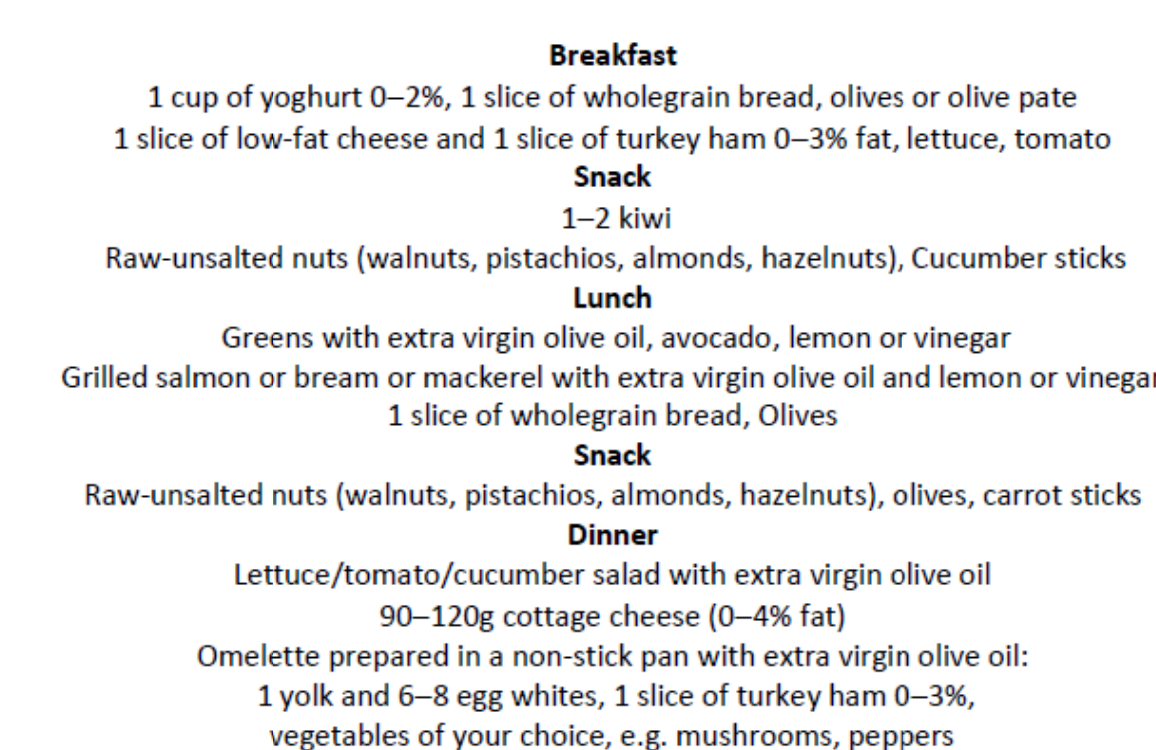
Figure 2. A sample of the modified MedDiet plan.